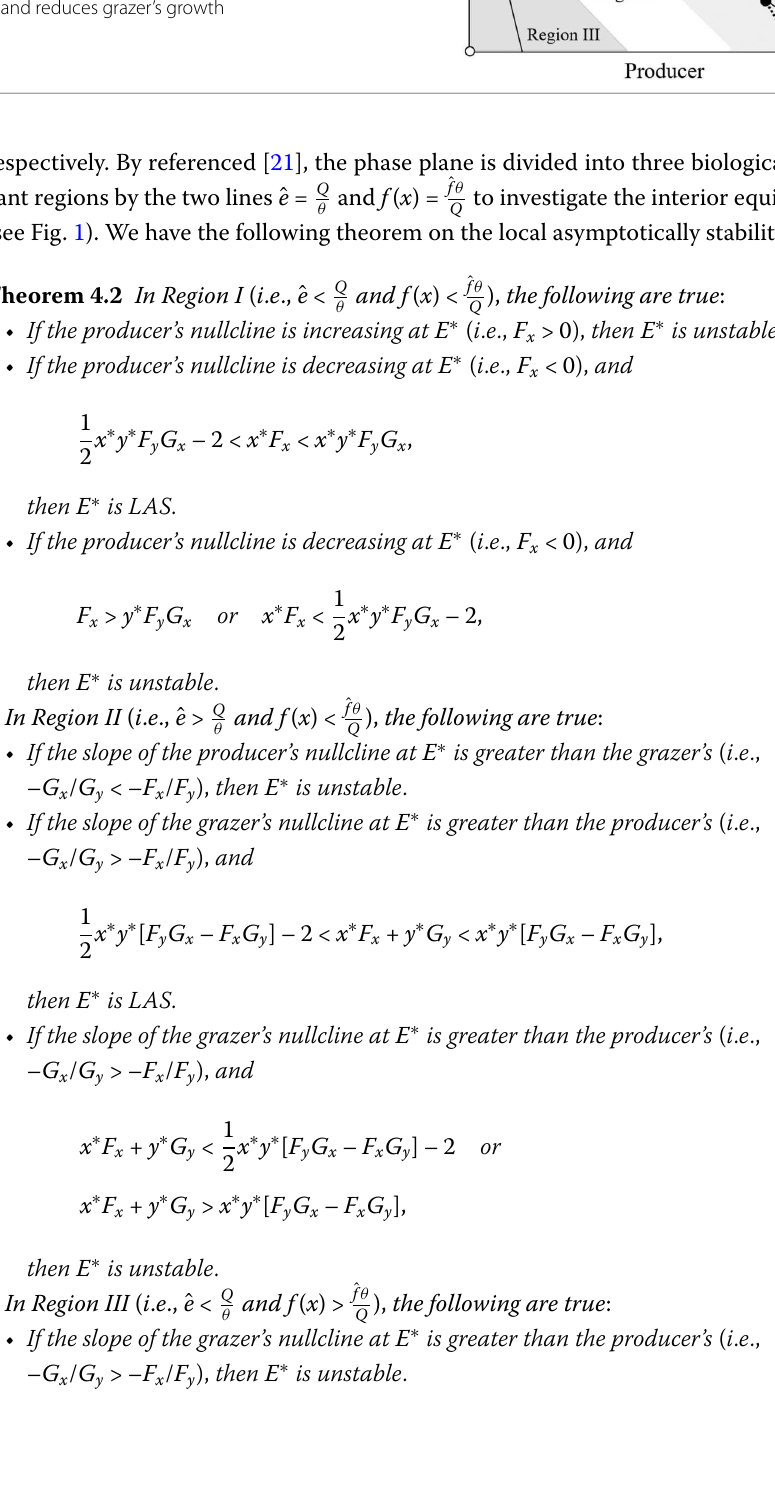
Figure 1 Phase plane for system (2.4). The lines ˆ f θ ˆ e = Q split the phase plane into three θ and f ( x ) = Q biological significant regions. Region I is defined by ˆ f θ ˆ e < Q , where P is neither limiting nor θ and f ( x ) < Q in excess. Region II is defined by ˆ e > Q θ (always ˆ f θ f ( x ) < from Lemma 2.4.1, [21]), where grazer’s Q growth is limited by a deficiency of P. Region III is ˆ f θ , where P is in excess defined by ˆ e < Q θ and f ( x ) > Q and reduces grazer’s